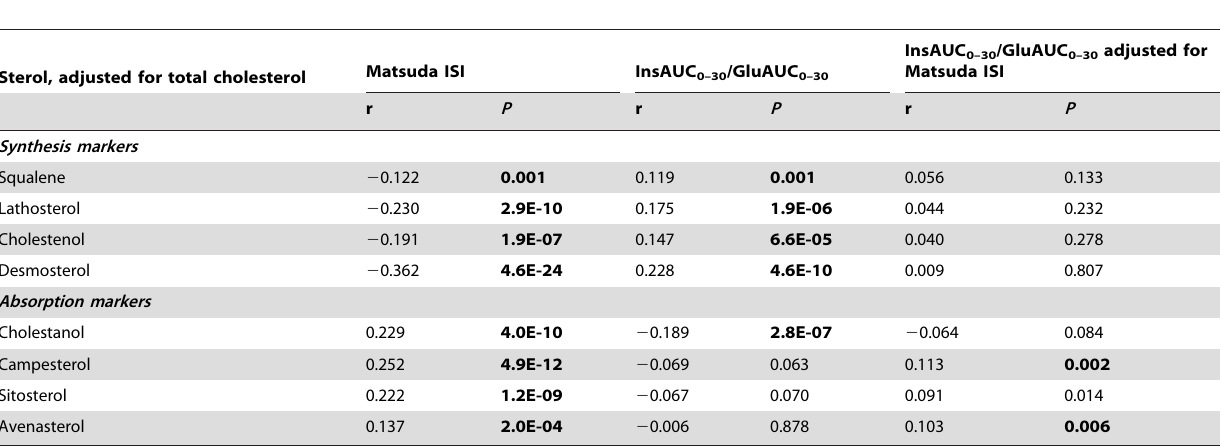
Table 1. Partial correlations of sterol levels indicating cholesterol synthesis and cholesterol absorption with insulin sensitivity and insulin secretion adjusted for age, BMI, smoking and physical